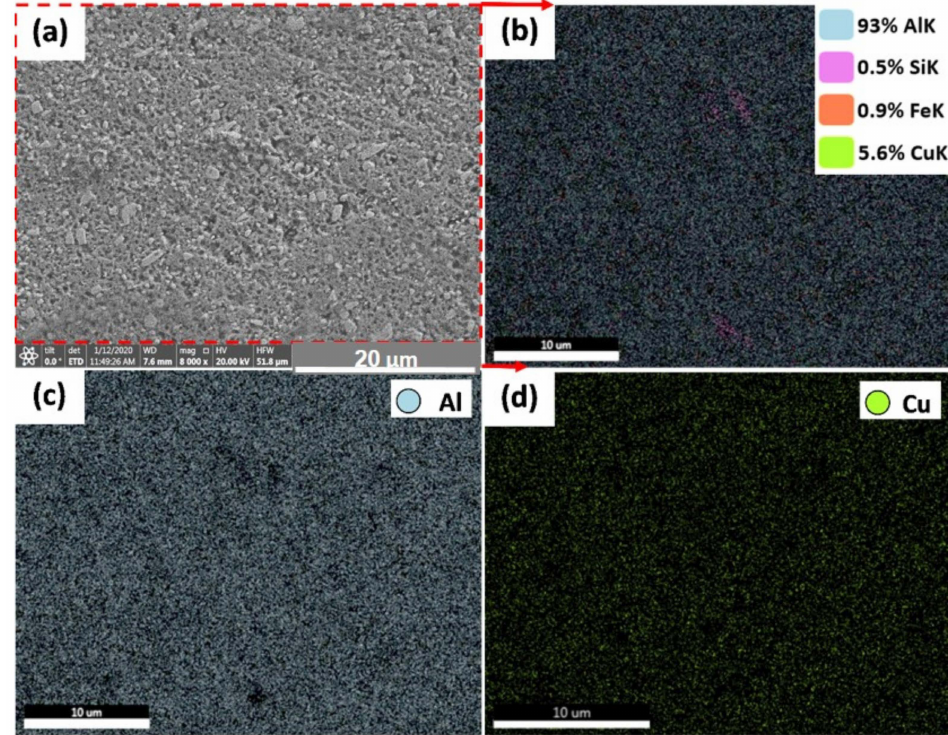
Figure 11. Elemental map distribution of AA2011-O AMPs produced at 200 rpm and 1 mm/min: ( a ) SEM of AMPs, ( b ) map distribution of all alloying elements, and ( c , d ) map distribution of Al and Cu,